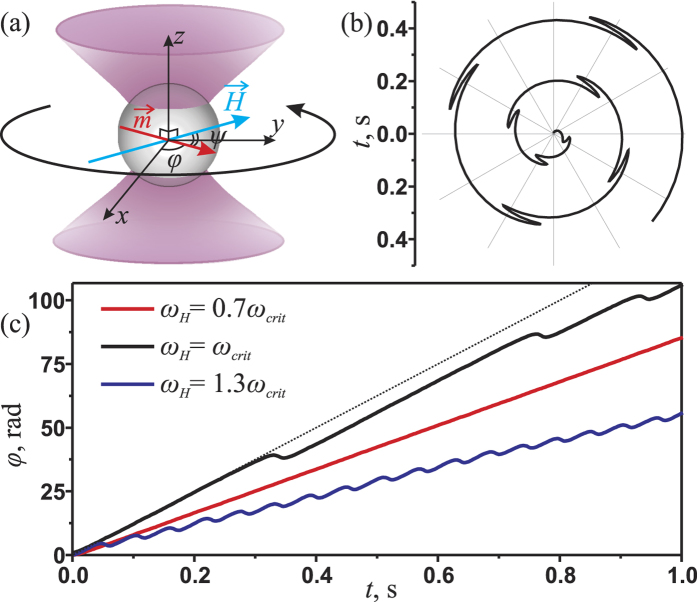
Schematic of the detection of Brownian torque on an optically trapped magnetic microparticle (panel (a)). Brownian dynamics simulations of the microparticle’s rotation angle φ as a function of time in polar coordinates (panel (b)) for ωH = 1.3ωcrit and in linear coordinates (panel (c)) for ωH = ωcrit (black curve), ωH = 0.7ωcrit (red curve), and ωH = 1.3ωcrit (blue curve); the dashed line represents φ = ωcritt. Langevin parameter equals to 250.